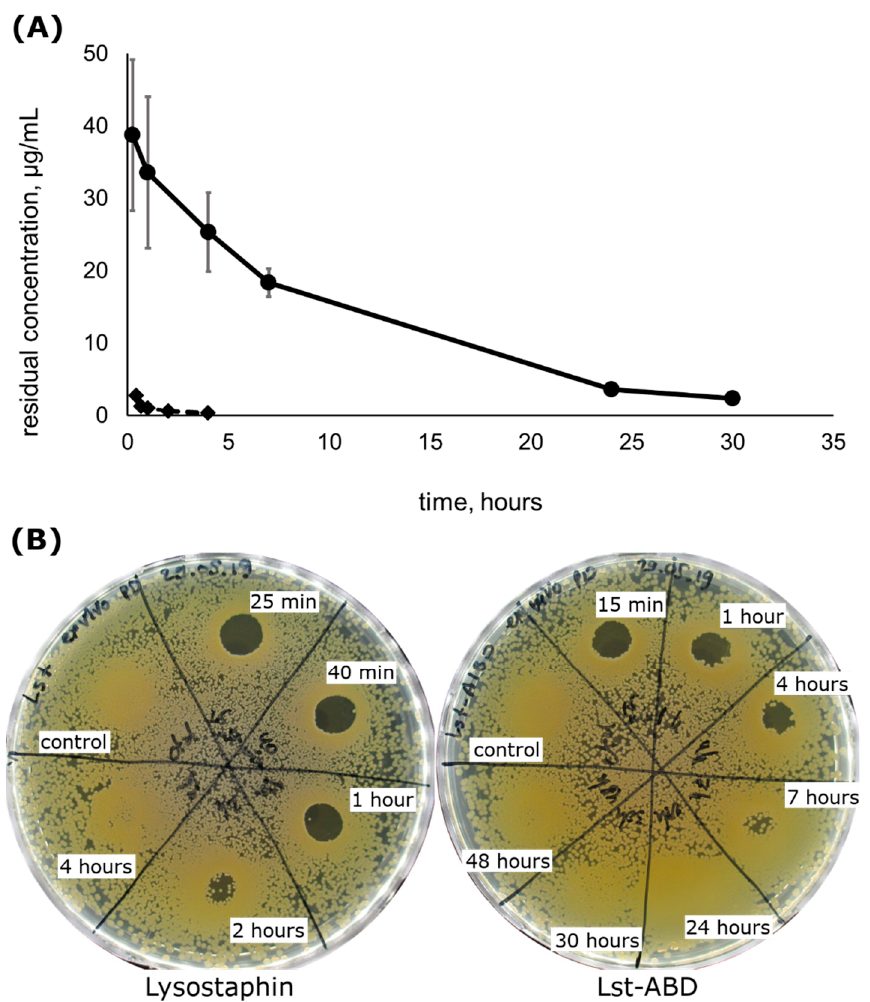
Figure 3. Pharmacokinetics and ex vivo pharmacodynamics of Lst-ABD in comparison to lysostaphin. ( A ) Residual concentrations of Lst-ABD (circles) and lysostaphin (diamonds) in rat plasma. Mean values from n = 3 (Lst-ABD) and n = 4 (lysostaphin) animals are shown, the error bars represent standard deviation. ( B ) Residual bactericidal activity of rat plasma towards S. aureus ATCC 29,213 at different timepoints after injection. Lysostaphin pharmacokinetics data in ( A ) are reproduced from [25], ex vivo pharmacodynamics data for both proteins in ( B ) were obtained in this work.